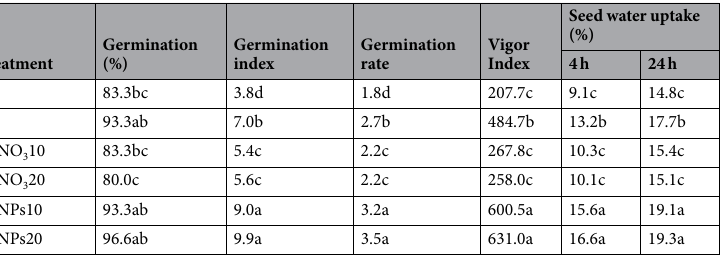
Table 1. Impact of different priming agents on germination percentage, germination index, germination rate, vigor index and seed water uptake. Means, in each column, followed by similar letter are not significantly different at the 5% probability level-using Duncańs Multiple Range